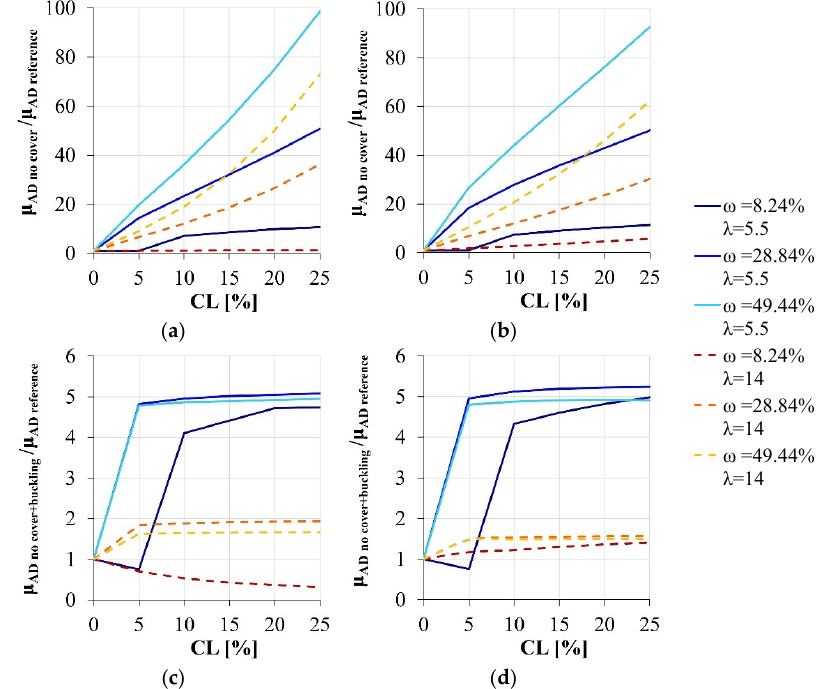
Figure 9. Local ductility variation due to the corrosion degradation: comparison between the simplified models and the reference section. ( a ) ν = 25.65%, section modeled disregarding the concrete cover vs. reference section. ( b ) ν = 15.39%, section modeled disregarding the concrete cover vs. ref ‐ erence section. ( c ) ν = 25.65%, section modeled disregarding both the concrete cover and the buck ‐